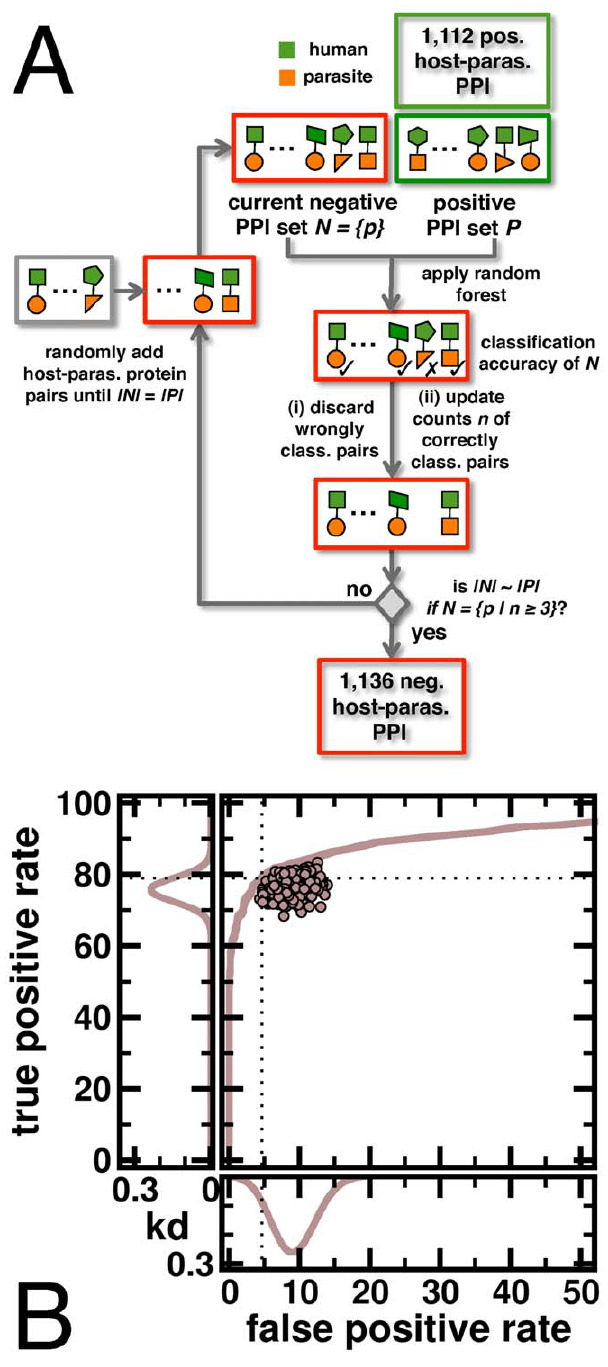
Figure 2. Determination of a negative interactions set. ( A ) As a positive training set I utilized 1,112 interactions between the human host and the parasite P. falciparum that have been previously inferred from protein structures. A non-interacting training set of equal size was constructed by randomly sampling pairs of human and parasite proteins that did not appear in the positive training set. Applying the random forest algorithm pairs of proteins that were incorrectly classified as interacting were discarded, and counts of correctly classified pairs were updated. If the number of pairs in the negative set that were sampled at least 3 times was roughly the size of the positive training set, the procedure terminated. Otherwise, the negative set of was filled with randomly sampled protein pairs until positive and negative training sets had the same size again. Previously